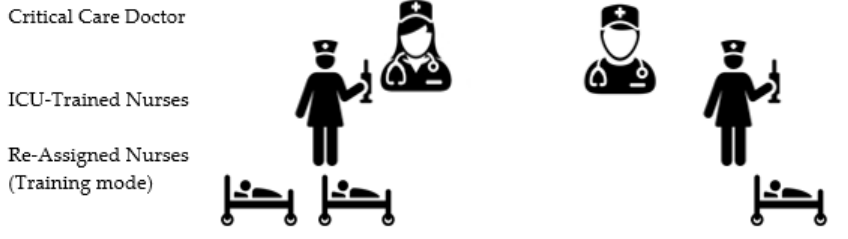
Figure 7. Training preparation for tiered staffing strategy for COVID-19 pandemic preparation. Rationale